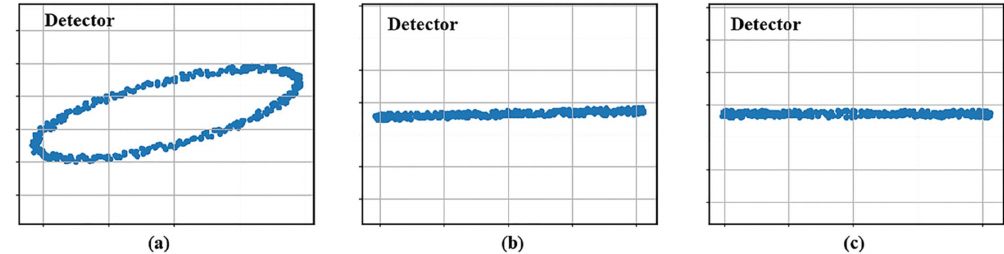
Figure 6 ( a ) Initial trajectory with tilted rotation axis. ( b ) Trajectory after coarse alignment. ( c ) Trajectory after fine